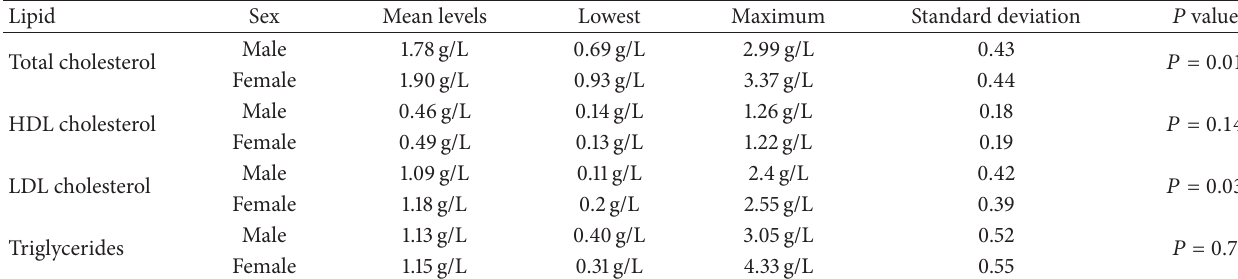
Table 2: Comparison of the lipid profile in men and women.